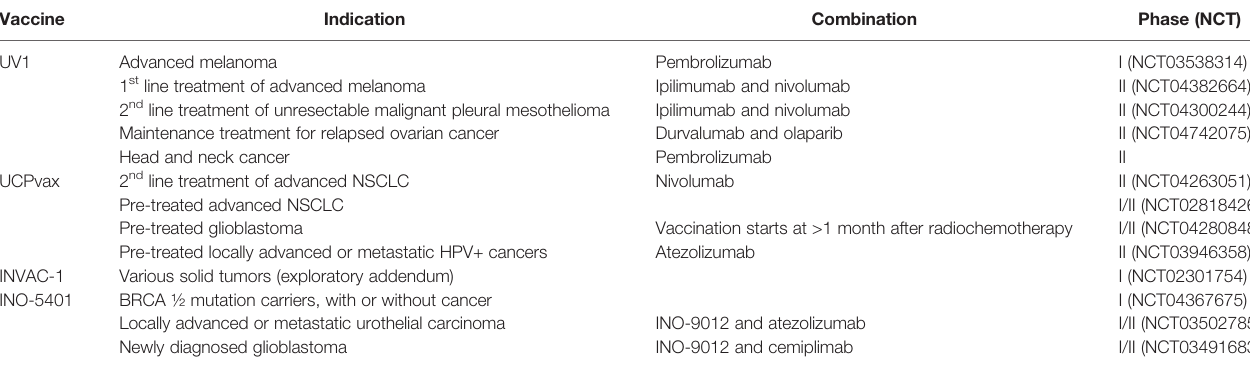
TABLE 2 | Several hTERT targeting TCVs are currently evaluated in active clinical trials and are often combined with different checkpoint inhibitors.